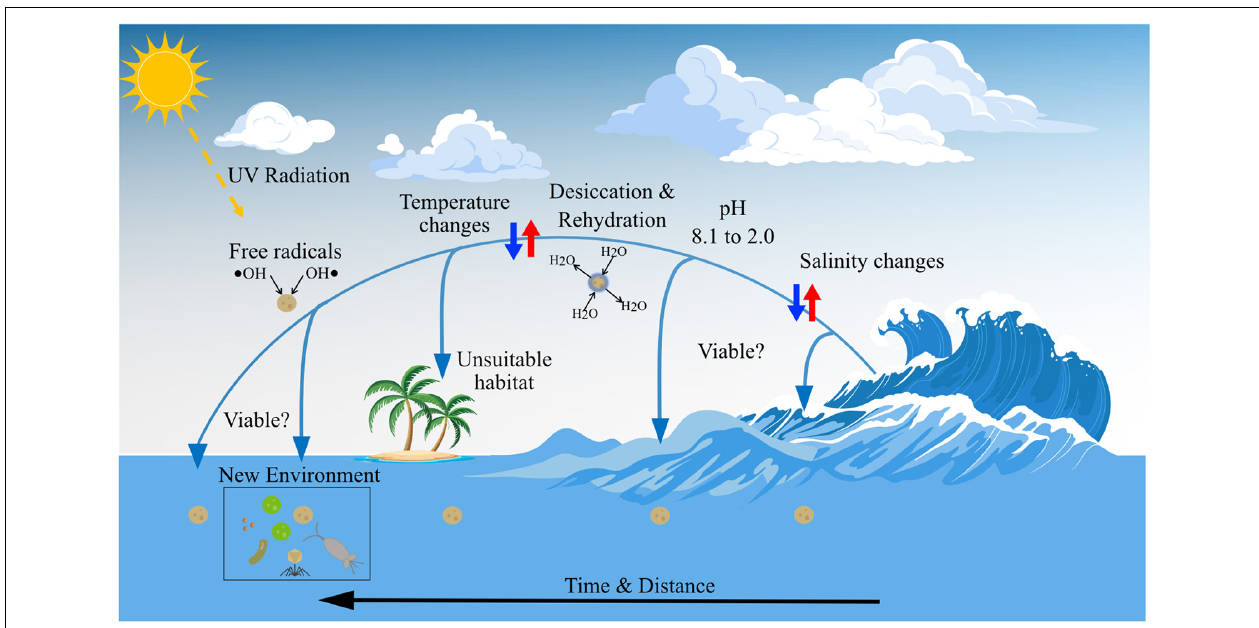
FIGURE 5 | Marine microorganisms are exposed to stressors in the atmosphere that potentially reduce viability: changes in water salinity and pH, temperature change, desiccation, and rehydration, exposure to free radicals and other oxidants, exposure to solar radiation (including UV). Other stressors include the rapid rates of environmental change that can occur on transport across the air-sea interface, and deposition in an unsuitable environment. The vector art used in this figure was downloaded from